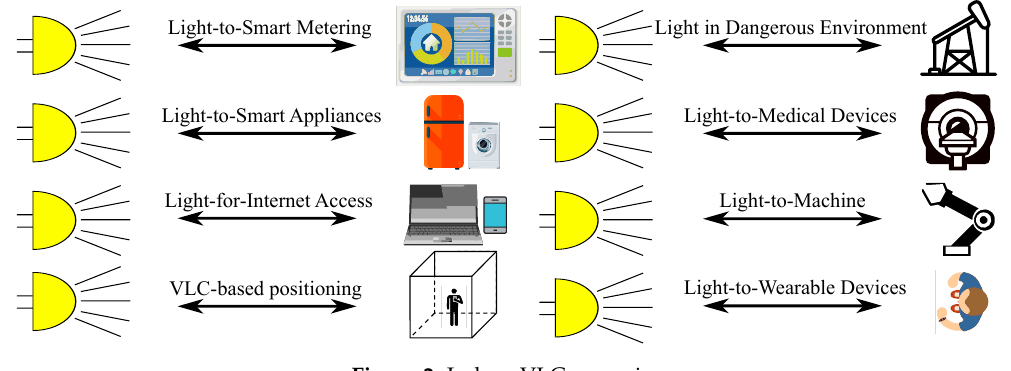
Figure 2. Indoor VLC